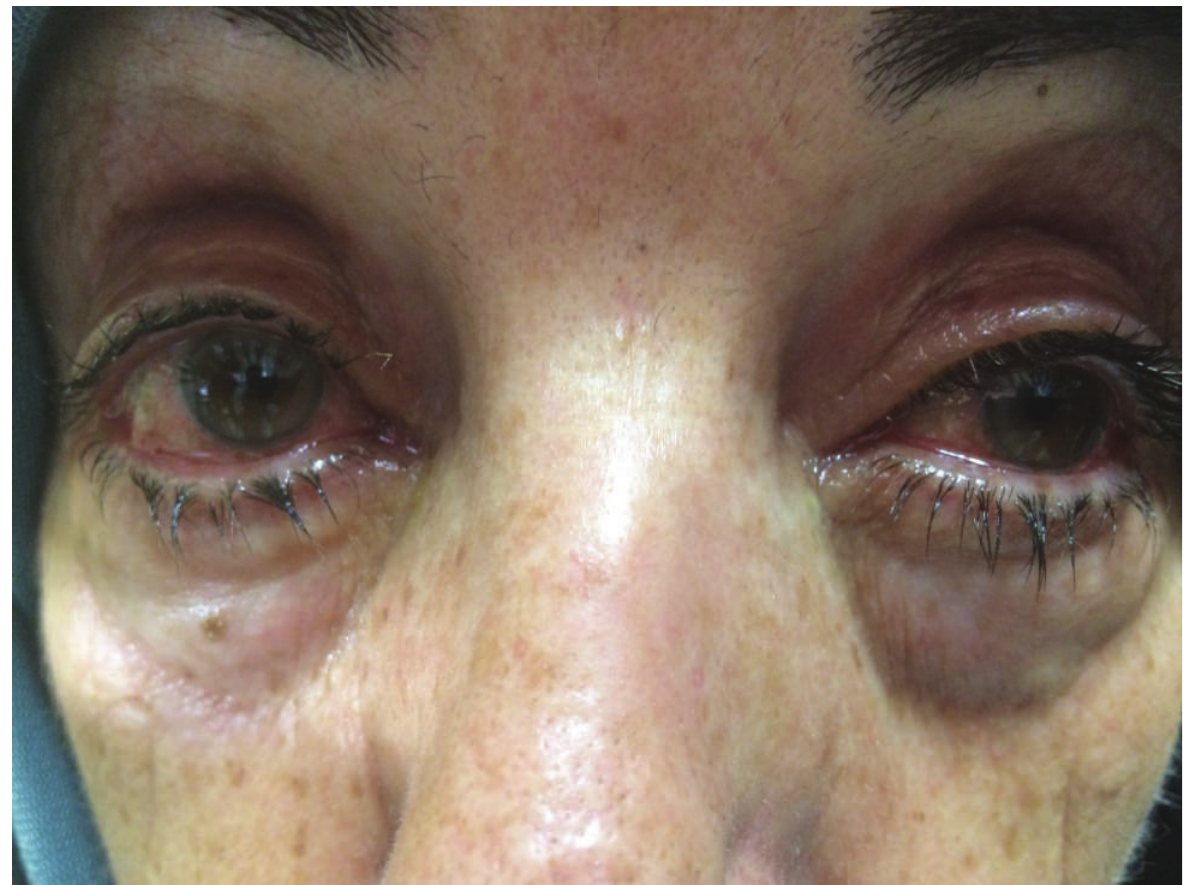
Figure 1. Adenoviral conjunctivitis presenting as bilateral watery